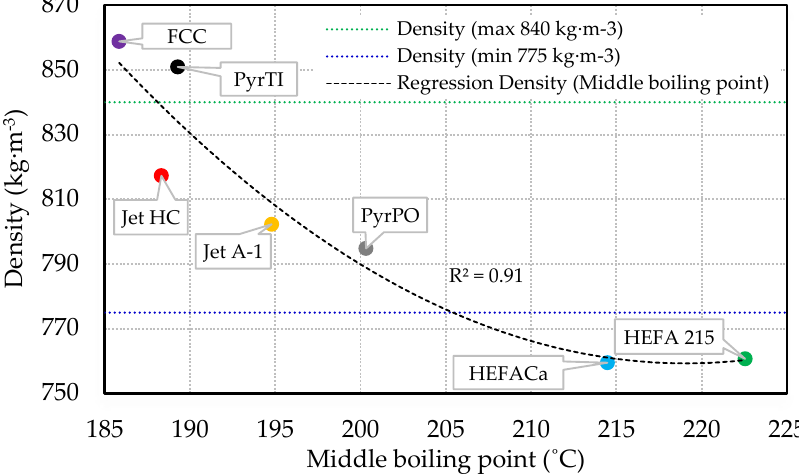
Figure 7. Density relation to the middle boiling point of the samples studied.